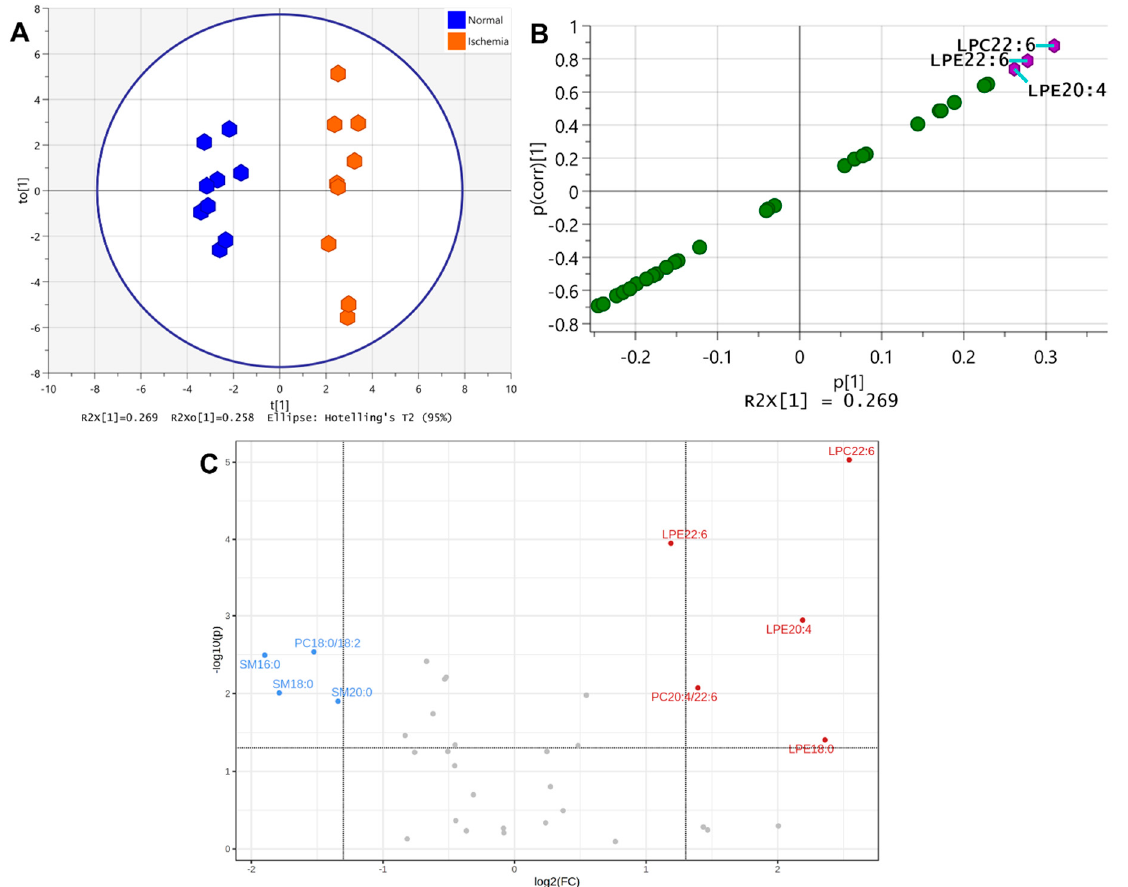
Figure 3. ( A ): The scatter plot of OPLS-DA on lipids in normal and ischemic rat brain parenchyma. ( B ): S-plot of OPLS-DA on lipids in normal and ischemic rat brain parenchyma. Lipid species with p(corr)[1] > 0.7 or < − 0.7 are identified (purple hexagons). ( C ): Volcano plot analysis on lipids in normal and ischemic rat brain parenchyma. Horizontal dotted line denotes − log10(p) of 1.301. Left vertical dotted line denotes log2(FC) of − 1.322 (i.e., FC = − 2.5; FC: fold change), and the right vertical dotted line denotes log2(FC) of 1.322 (i.e., FC = 2.5) Lipids with − log10(p) > 1.301 and log2(FC) > 1 or < − 1 are identified. See text for